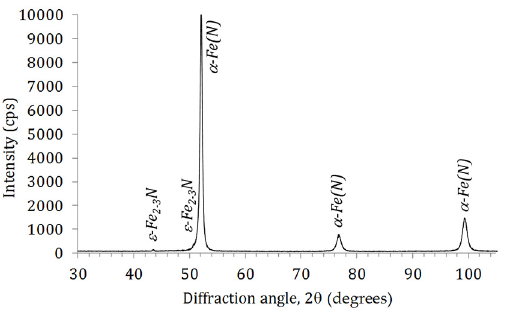
Figure 6. X-ray diffraction patterns of the ion-nitrided tool steel substrate.